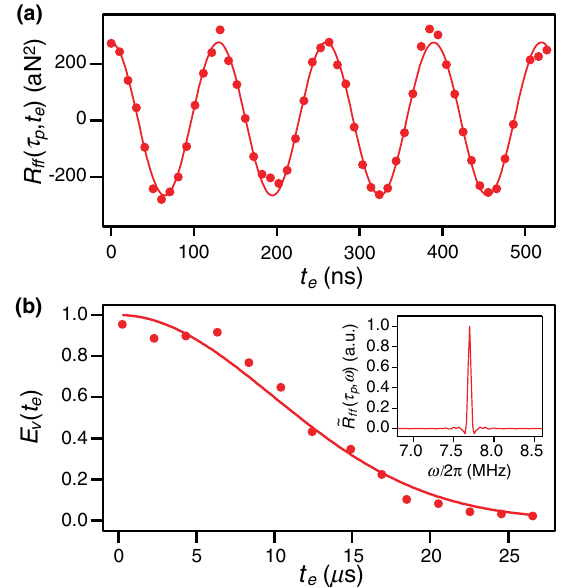
FIG. 3. Free precession in a statistically polarized sample. (a) Autocorrelation of the force signal R ff ð (cid:5) p ; t e Þ and fit to a cosine. (b) Amplitude of the free precession and fit to a Gaussian. From the fit, we infer that T (cid:5) 2 ¼ 14 (cid:1) s . Inset: Proton NMR spectrum of the statistically polarized sample. To obtain the spectrum, the data from (b) are linearly interpolated between points to give the precession envelope. The envelope is multiplied by a cosine at the measured precession frequency and cosine transformed to yield the spectrum. We attribute non- Gaussian features in the spectrum to deviations in the time record from ideal Gaussian behavior, especially at short